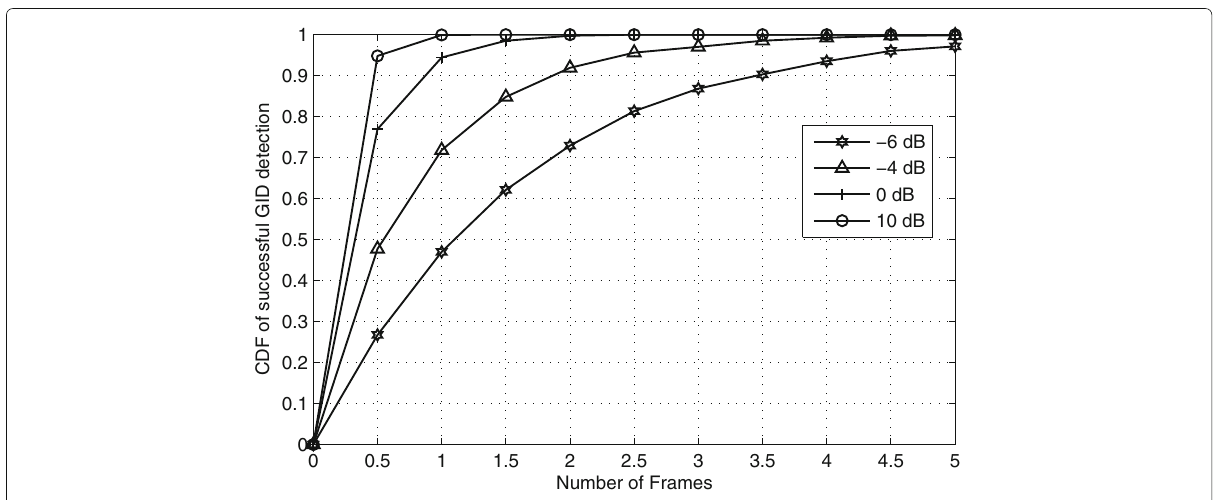
Fig. 11 CDF of the cell-ID detection over number of frames